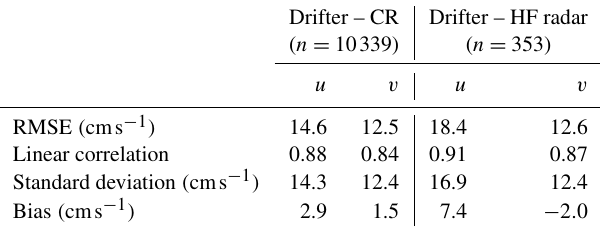
Table 2. Summary of the model velocity validation performed by comparing GPS drifter velocities with the CR and HF radar veloci- ties; the surface velocity components of the latter were interpolated to the drifter velocities. Details are given in the text. A positive bias denotes that drifter velocities are larger than the velocities of the CR or HF radar. The corresponding scatter plots are given in Fig. S4. n is the number of